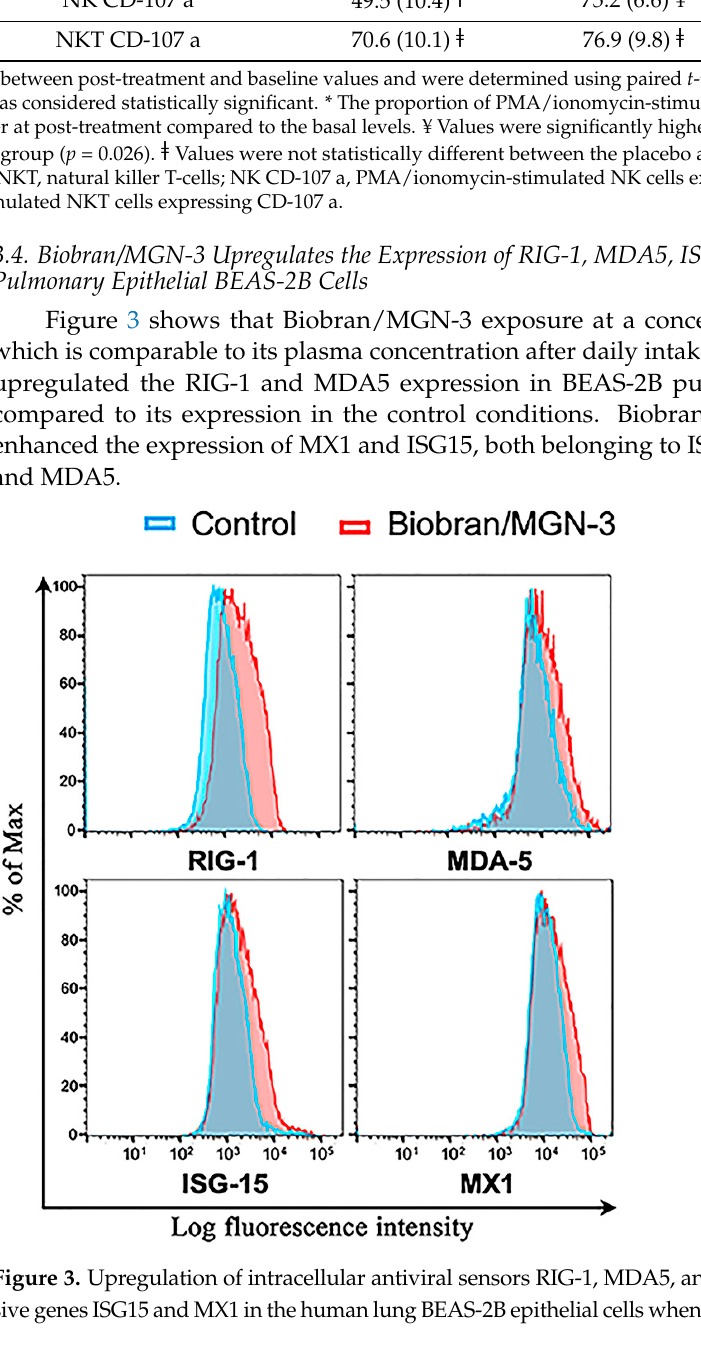
Figure 3. Upregulation of intracellular antiviral sensors RIG-1, MDA5, and their downstream respon- sive genes ISG15 and MX1 in the human lung BEAS-2B epithelial cells when exposed to Bi- obran/MGN-3 (100 μ g/mL) for 72 h. Histograms depict gene expression as determined by the log fluorescent intensity on the x-axis, whereas % of cells normalized to the maximal number on the y- axis. At each fluorescent intensity, higher % of cells exist due to shifting of the curve to the right. Each histogram is representative of three flow cytometry experiments.